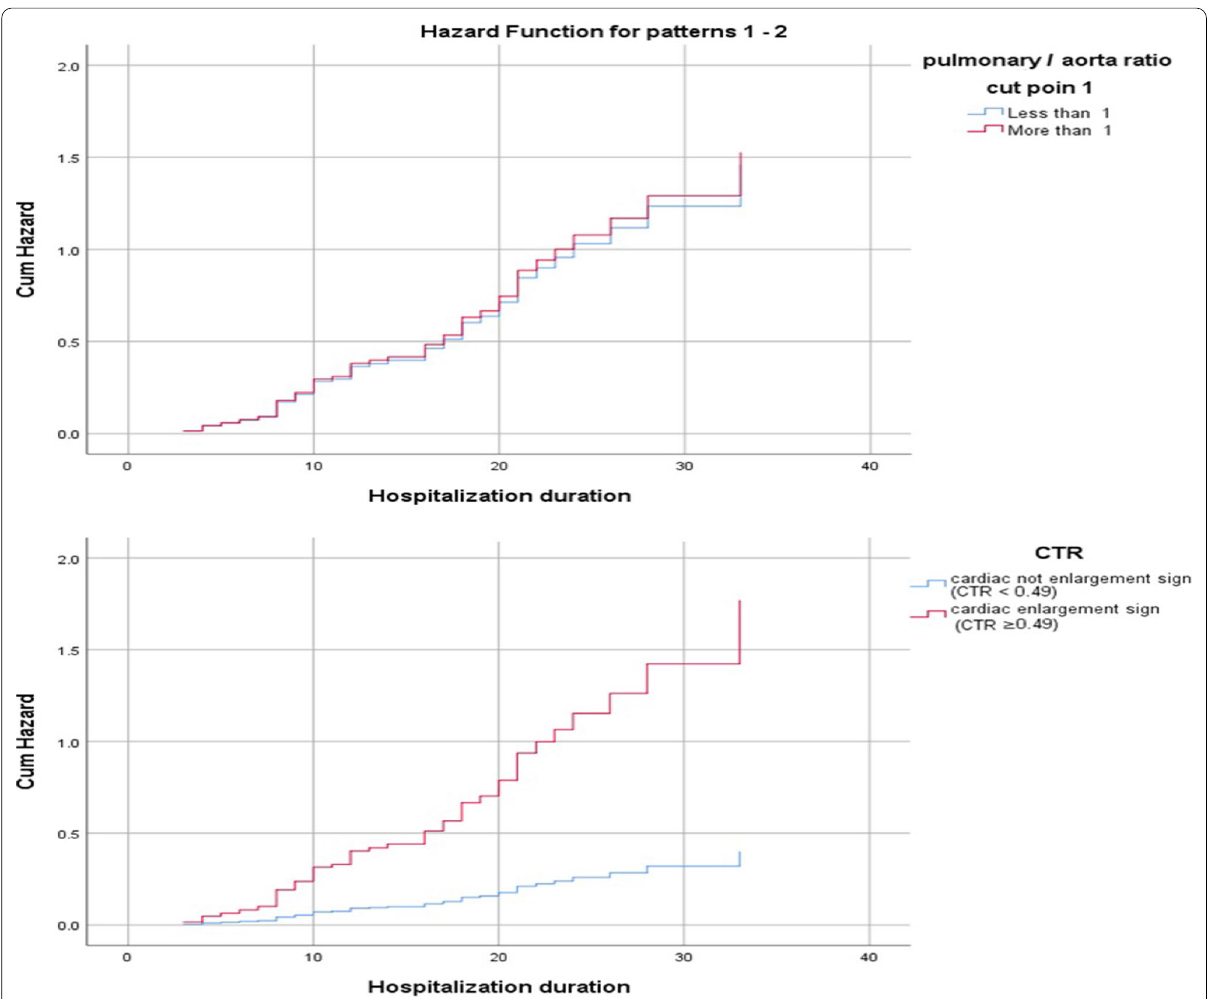
Fig. 3 Cumulative HR function for death in COVID‑19 patients according to the pulmonary aorta and cardiothoracic ratios. The outcome was defined as death or recovery, and length of hospitalization was considered the time to outcome in the Cox regression